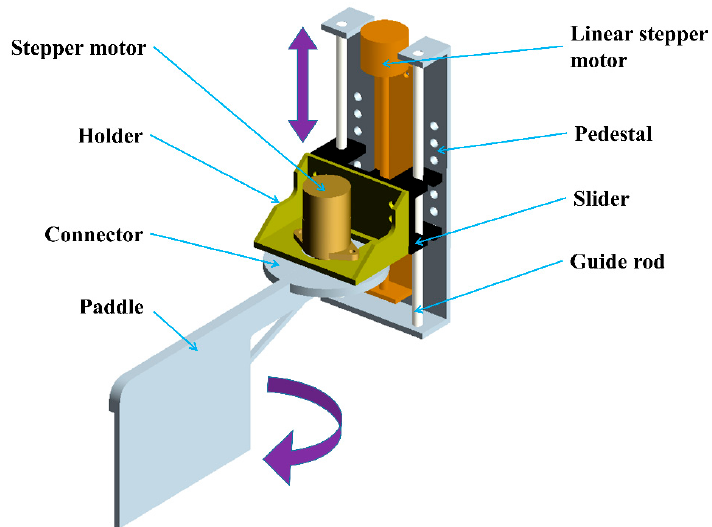
Figure 2. Computer aided design (CAD) model of the stroke mechanism. The two purple arrows represent the movement of the stroke mechanism on the vertical and horizontal